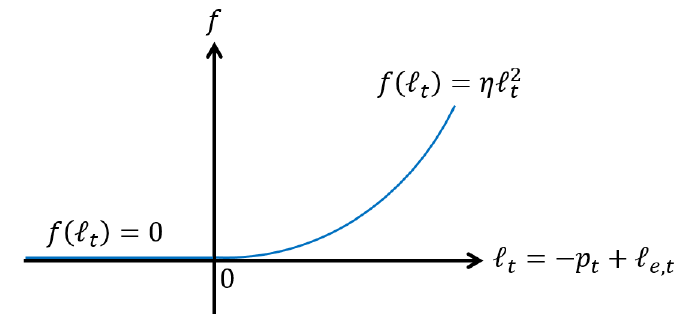
Figure 4. Cost/impact on the electrical grid of electric vehicles (EV) charging and PhotoVoltai (PV) production (through the net load (cid:96) t ) at time slot t . If PV production is higher (resp. smaller) than EV charging load, there is no (resp. a quadratic)